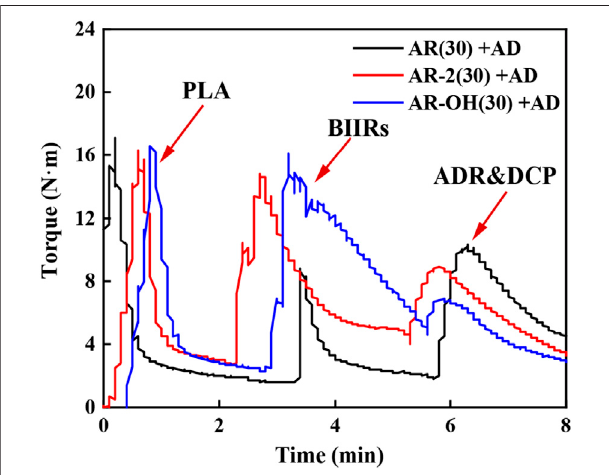
FIGURE3| TorquecurvesduringmeltmixingprocessofthePLA/ i -BIIRs blends.